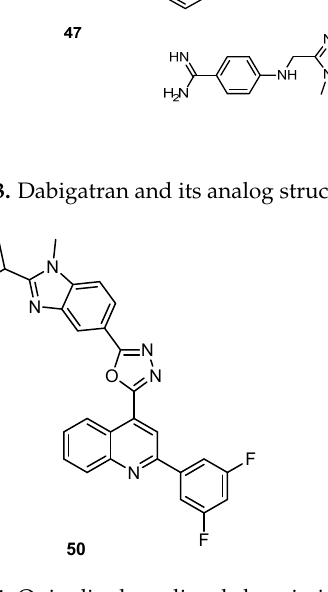
Figure 23. Dabigatran and its analog structures.